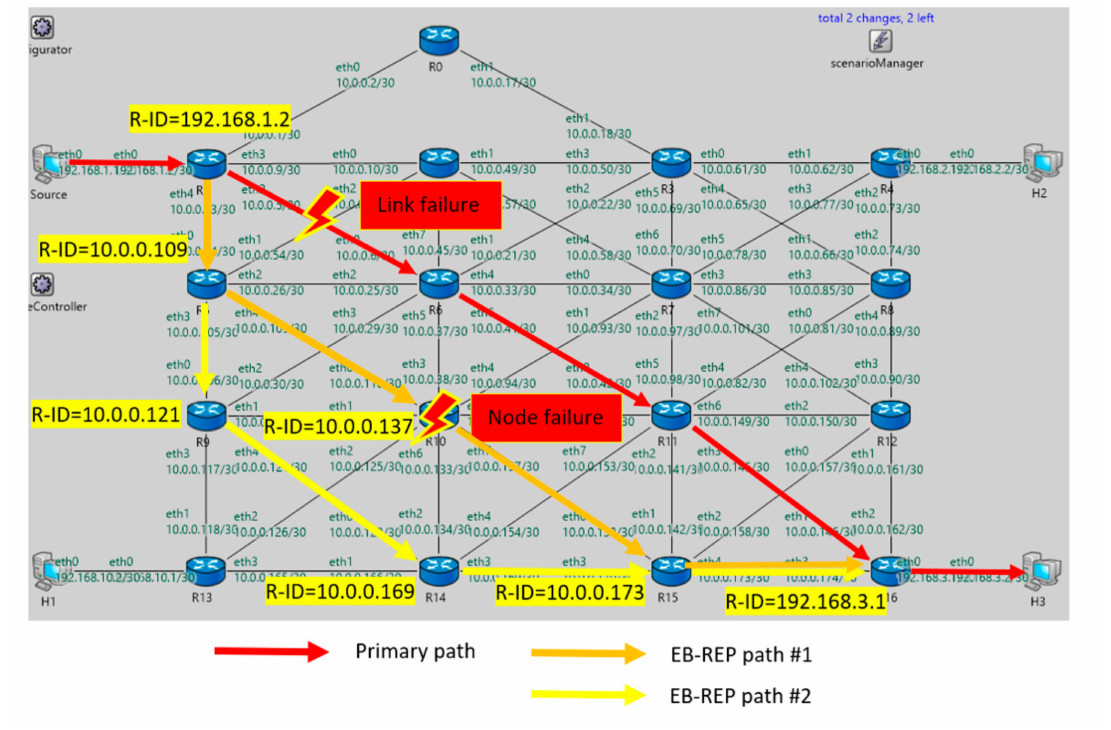
Figure 14. Visual output from the OMNeT++